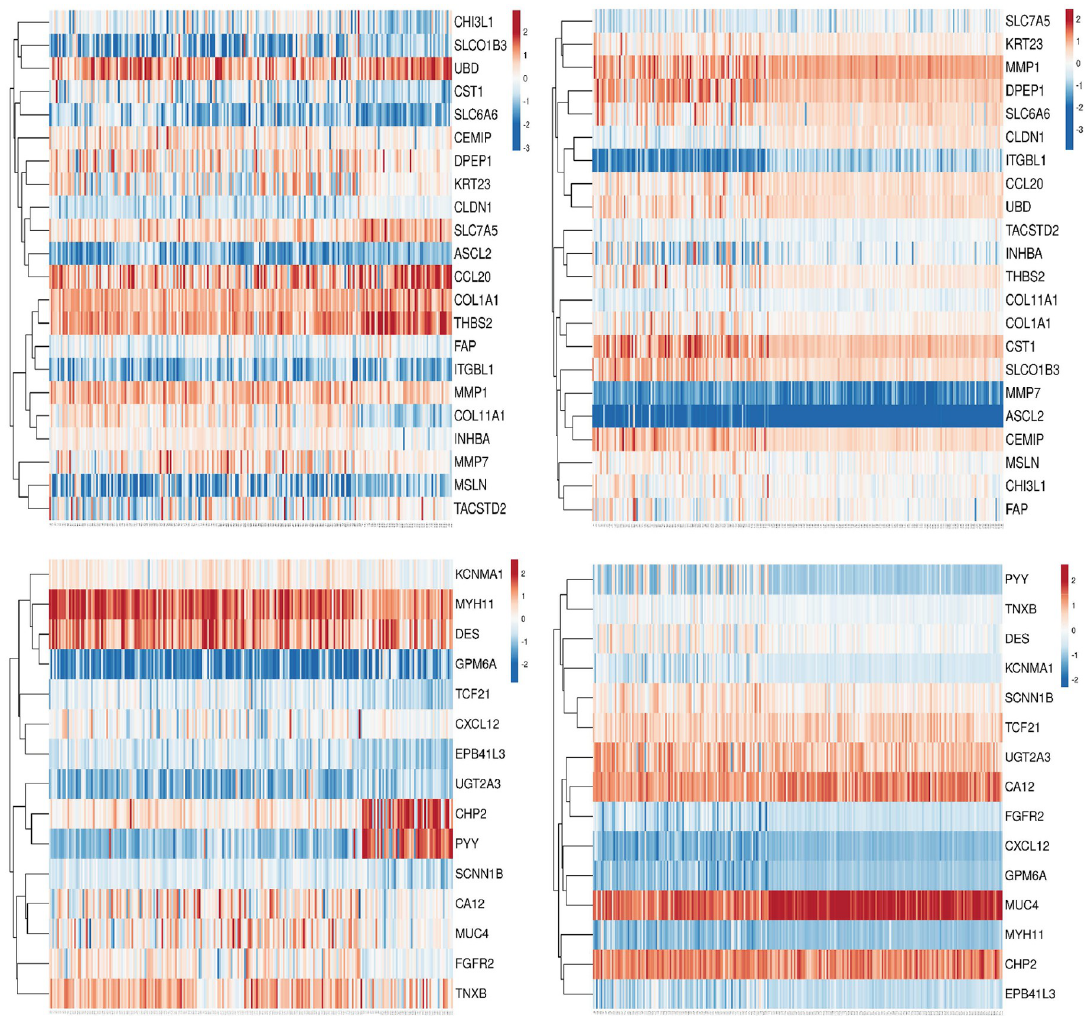
Fig 6. Heatmaps as for expression and methyaltion of validated-Differentially-Expressed-Genes-Differentially-Methylated-Genes (vDEGs-DMGs) based on our participants’ data. The top left corner) Expression values of over-expressed/hypo-methylated vDEGs- DMGs. The bottom left corner) Expression values of under-expressed/hyper-methylated vDEGs-DMGs. The top right corner) Methylation values of over-expressed/hypo-methylated vDEGs-DMGs. The bottom right corner) Methylation values of under- expressed/hyper-methylated